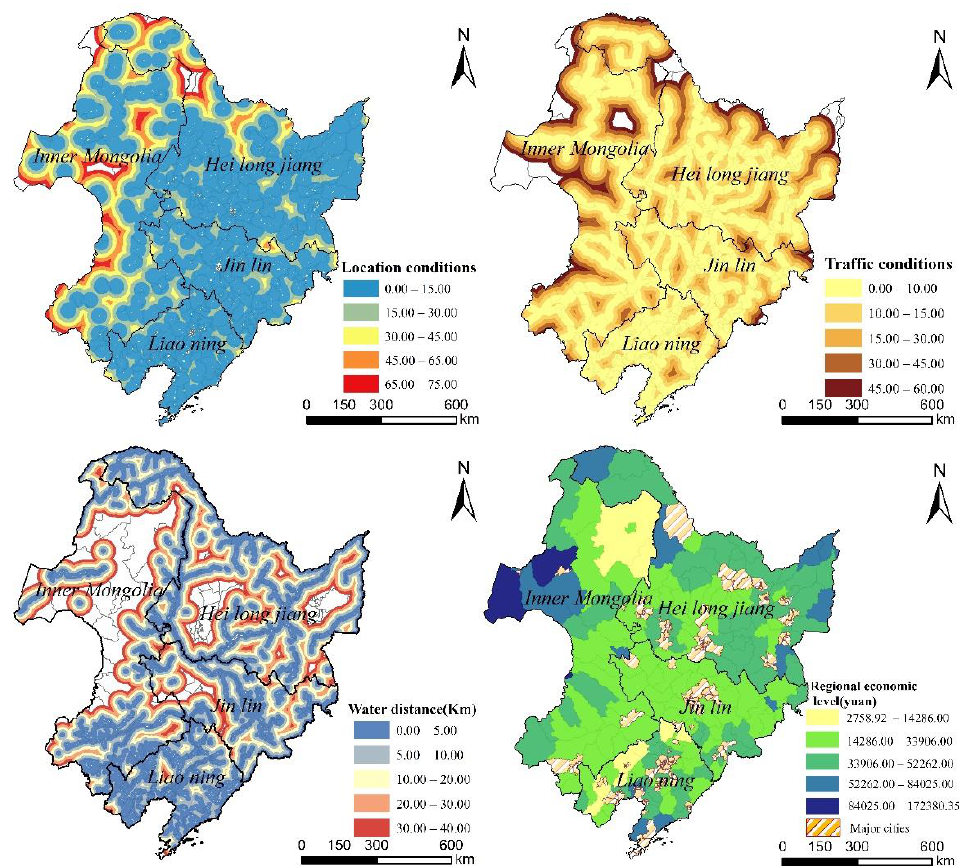
Figure 8. Spatial layout of each influencing factor.